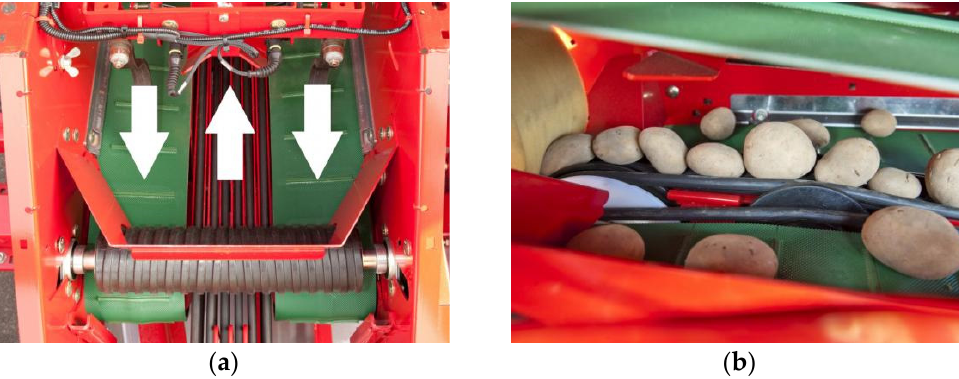
Figure 11. Moving-belt-type seed metering device. ( a ) The conveyor belt arrangement of the device. Reprinted with permission from ref. [58] Copyright 2022 Grimme Industries. ( b ) The working process of the device. Reprinted with permission from ref. [58] Copyright 2022 Grimme Industries.